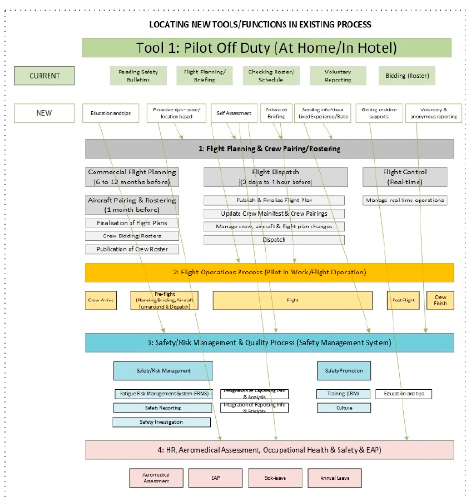
Figure A4. Future process.